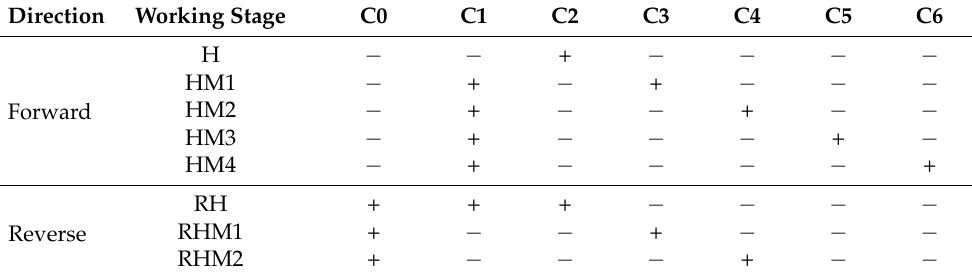
Table 6. HMCVT shift clutch logic. (+: engage; − separate).